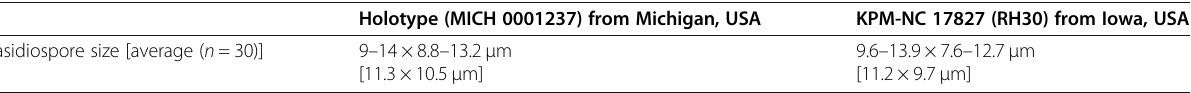
Table 2 Comparison of basidiospore dimentions between holotype of O. asterosperma var. potteri and a recently collected North American specimen (KPM-NC 17827) Holotype (MICH 0001237) from Michigan, USA KPM-NC 17827 (RH30) from Iowa, USA Basidiospore size [average ( n =